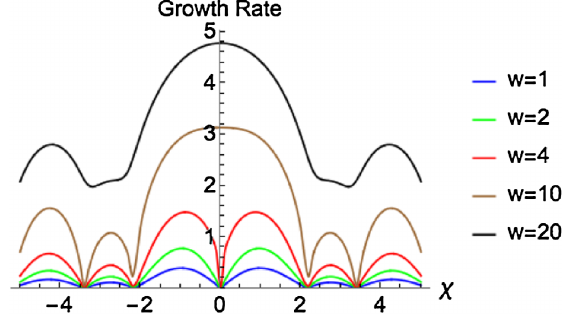
FIG. 4. Growth rates in units of 1 = T for the round chamber and zero gain.